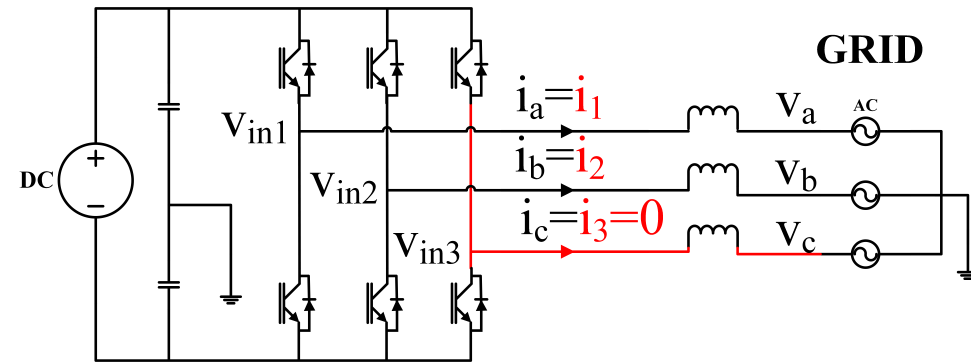
Figure 3. Representation of simulated grid connected inverter system with and without